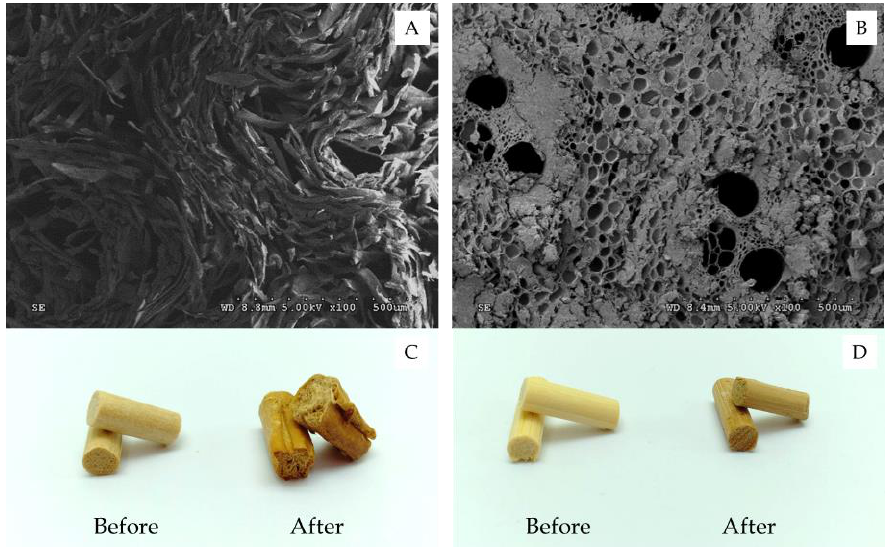
Figure 7. Scanning electron microscope (SEM) images of cigarette filter tips ( A ) and bamboo chopsticks ( B ) at 100× magnification, as well as the physical characteristics of the cigarette filter tips ( C ) and bamboo chopstick pieces ( D ) before and after butanol fermentation in SSJ medium.